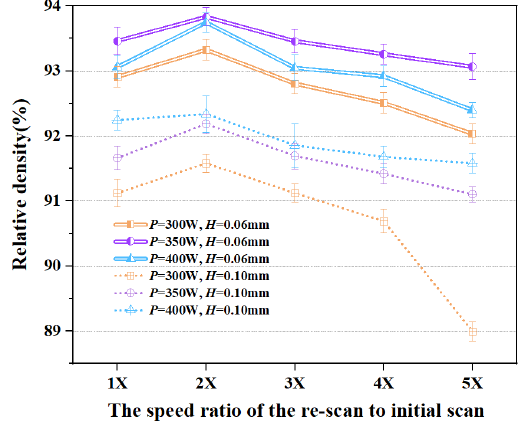
Figure 6. The relationship between the re ‐ scan to initial scan speed ratio and the relative density (the initial scan speed was fixed at 200 mm/s).